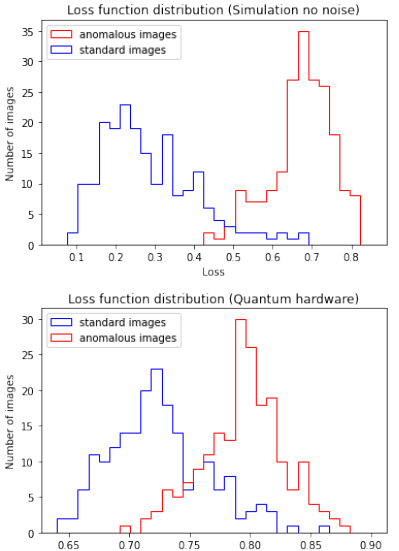
Figure 13. Quantum autoencoder loss function values distribution: simulated circuits with no noise ( top left ), simulated circuits with noise ( top right ) and a noisy quantum circuits ( bottom ). The graph was made using 200 normal data and 200 anomalous data, with 2048 shots each circuit. The loss function was one minus the probability of the | 111 (cid:105) state.